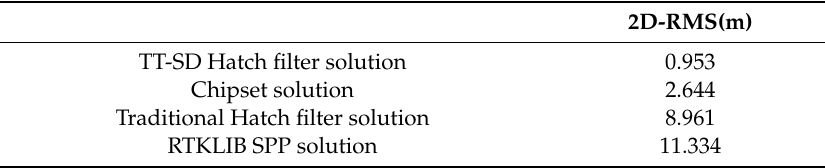
Figure 12. 2D positioning errors of the kinematic experiment. 2D error represents the square root of the sum of squared errors in the east and north directions. Note that the smoothing window width of the traditional Hatch filter is 600s. Table 2. RMS of the 2D positioning error of four solutions in kinematic experiments